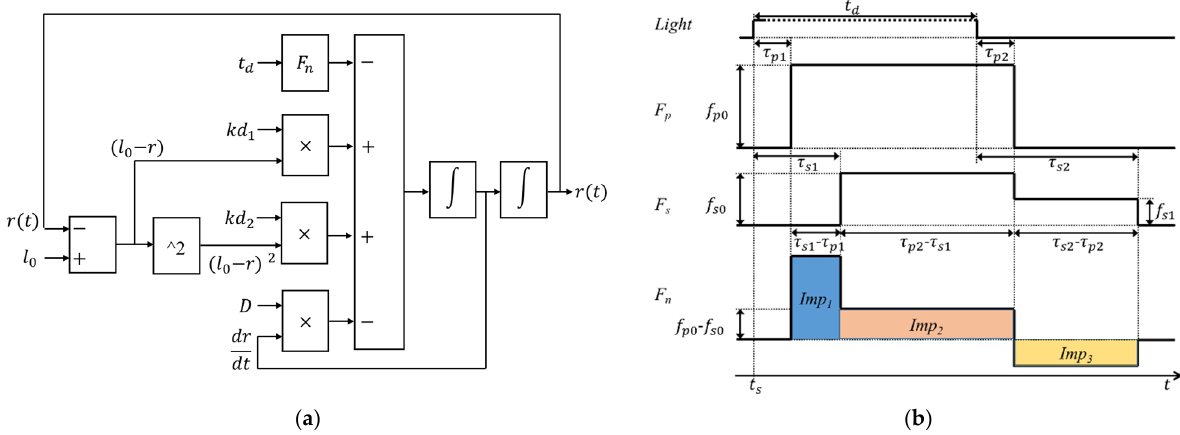
Figure 2. ( a ) Control block diagram of the pupillary light reflex inherent model and ( b ) timing diagram of the force originated from autonomic nervous system before and after a light stimulus.